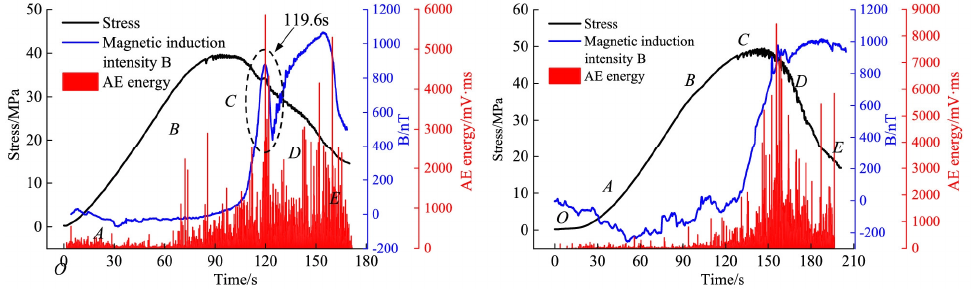
Figure 12. Results of Yin et al.’s research